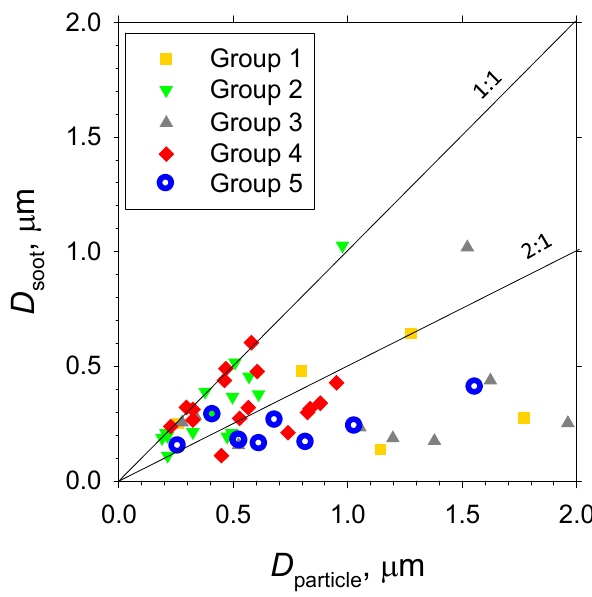
Figure 11. Scatterplot of particle sizes before and after water dial- ysis of soot-containing particles (i.e. soot-containing particle diam- eter and soot diameter) for sample groups